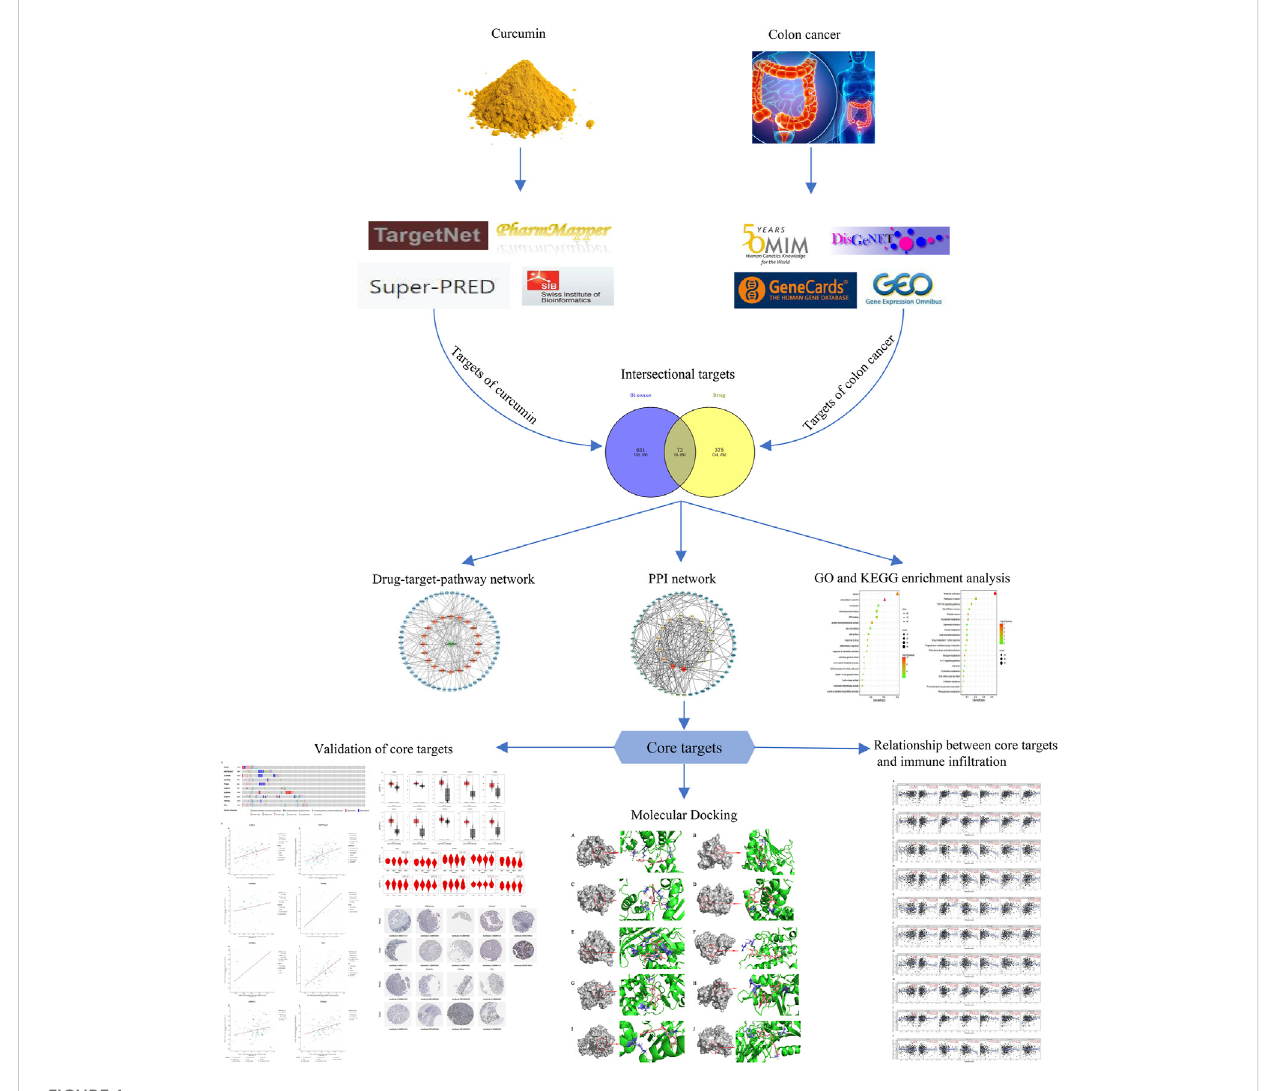
FIGURE 1 This study is a detailed fl ow chart of a network-based pharmacology